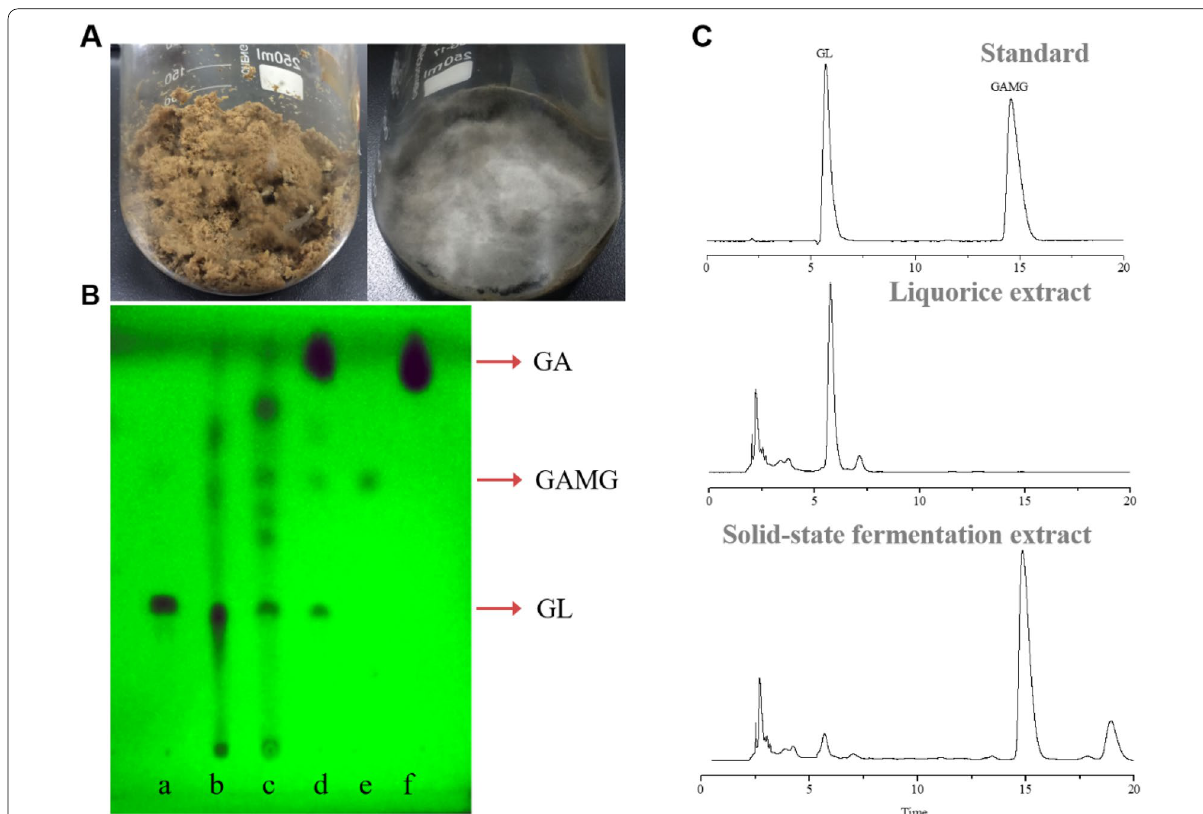
Fig. 1 C. globosum DX-THS3 can grow on licorice straw for GAMG production. Licorice straw was used as a medium for C. globosum DX-THS3 growth (left, A ). Depth fermentation was performed after 20 days (right, B ), and the product was analyzed by TLC (B, lane a: standard of GL; lane b: extract of licorice straw; lane c: extract of solid-state medium; lane d: mix standard of GL, GAMG and GA; lane e: standard of GAMG; lane f: standard of GA) and UPLC analyses ( C